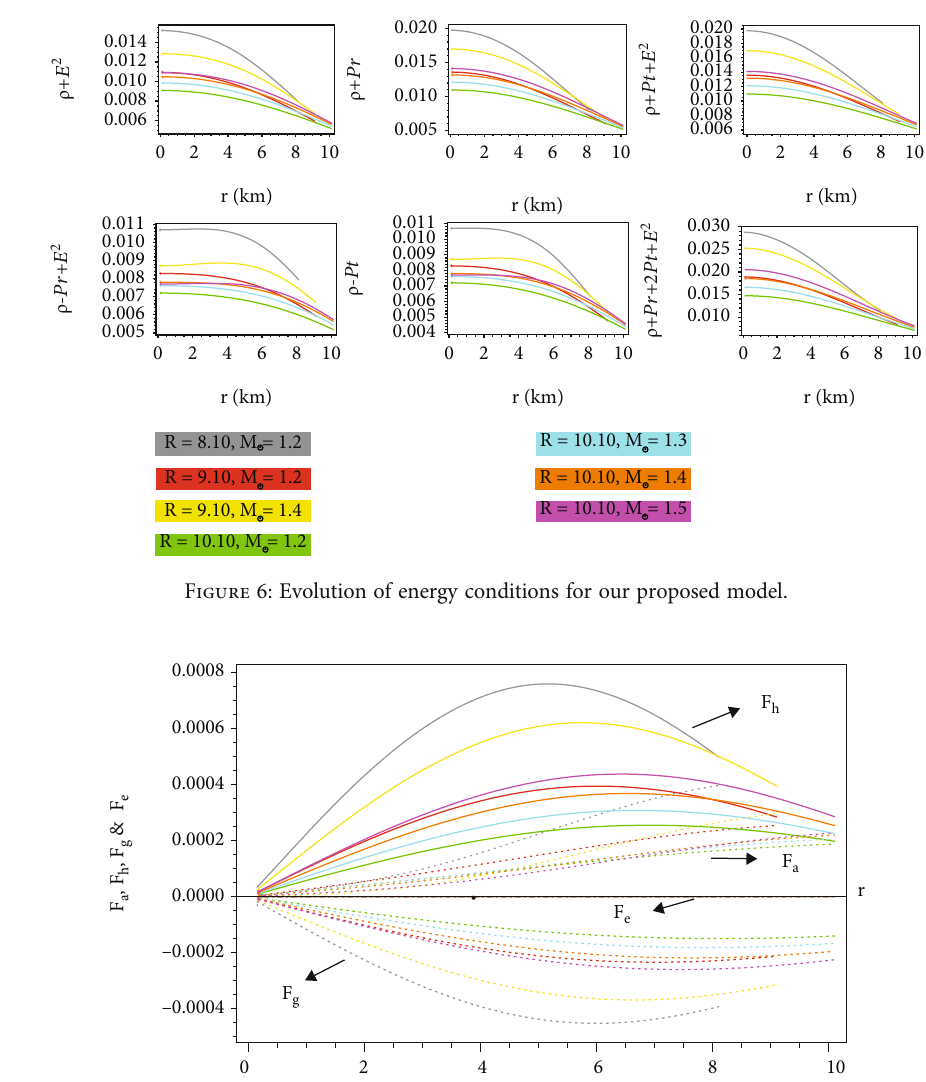
, F , F , and F h g a